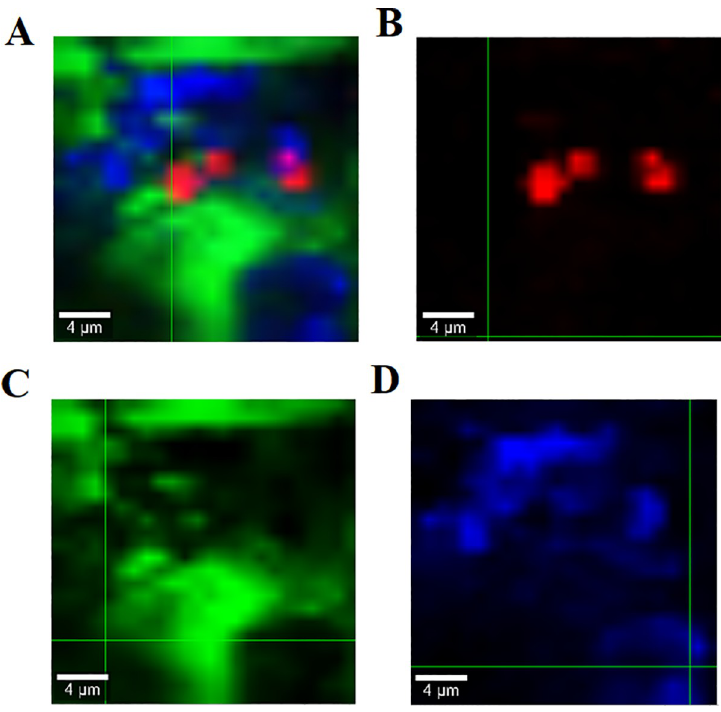
Fig 6. Raman mapping of formulation F3 (A) drug and excipient mixture, (B) Puerarin (C) Lactose, and (D) Mg-St.